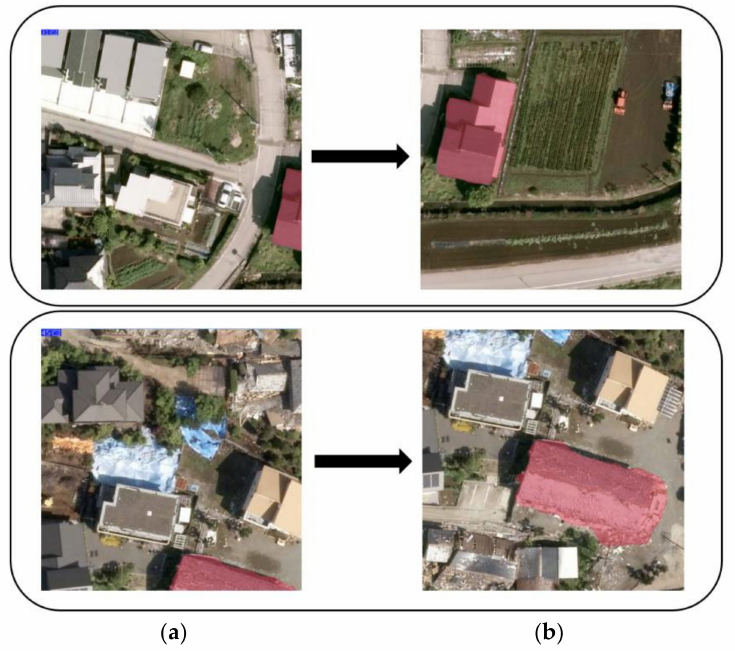
Figure 3. Samples of buildings located at the edge, which are marked by the red masks. ( a ) Original cutting with incomplete shapes; ( b ) adjusted cropping frames with complete building shapes.